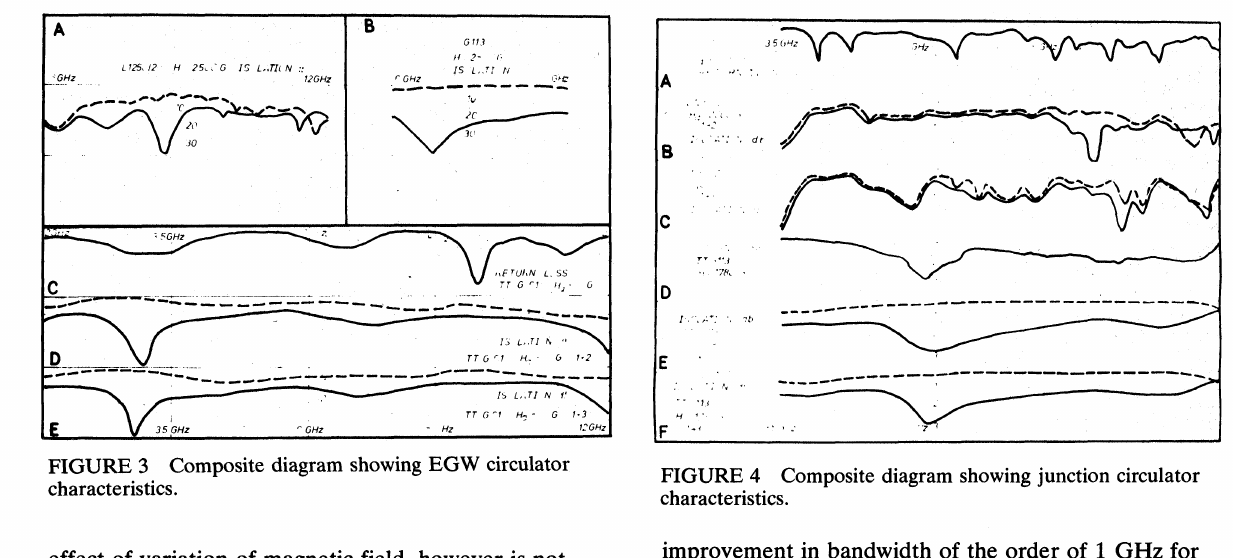
FIGURE 4 Composite diagram showing junction circulator